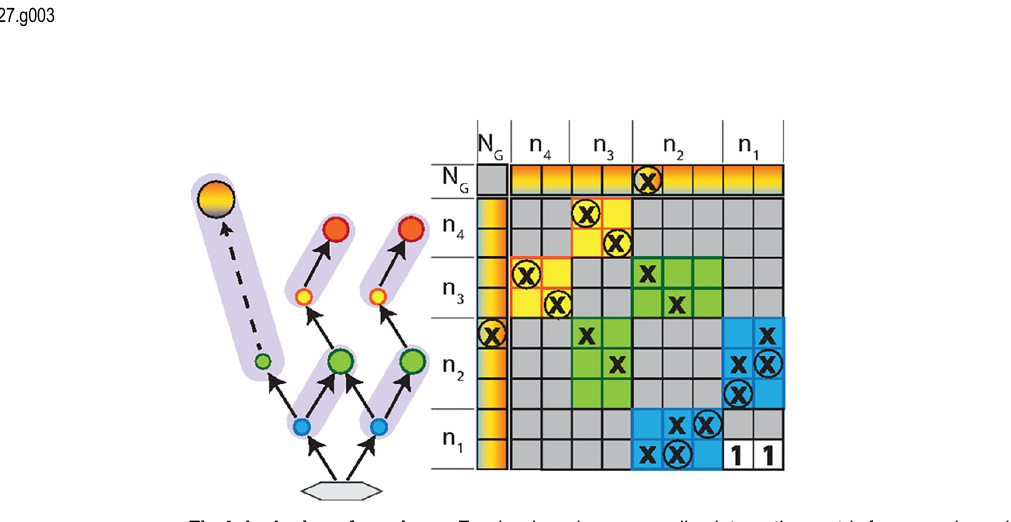
Fig 4. Inclusion of omnivory. Food web and corresponding interaction matrix for several species with sharp trophic levels and a single generalist omnivore. We only show its paired link in the network plot, but indicate all its interactions in the matrix.